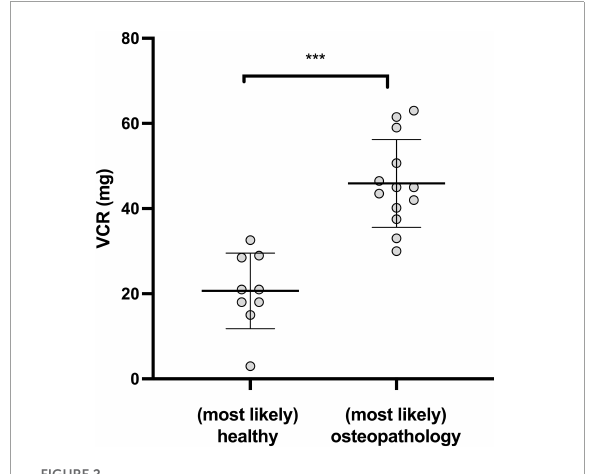
FIGURE2 Osteopathologies and Vincristine (VCR). Cumulative dosage of VCR in patients with (most likely) osteopathologies and (most likely) healthy survivors. (*** P <